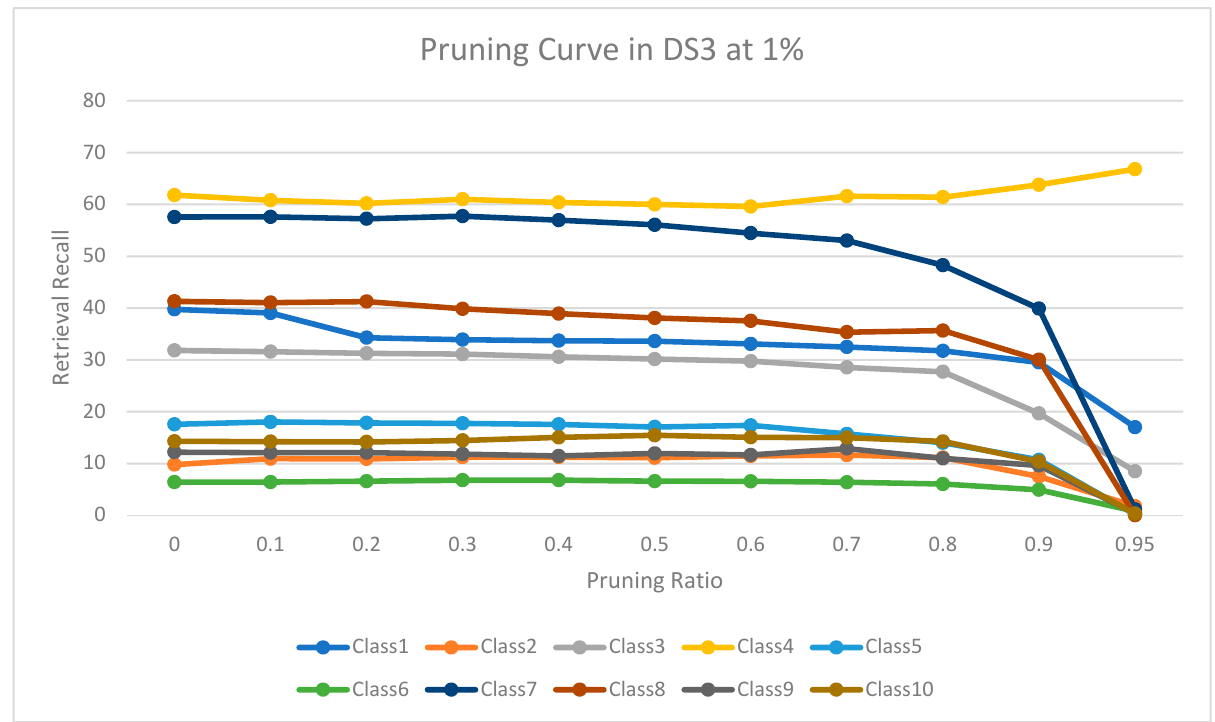
Figure 8. The level of retrieval recall values at different percentages of pruning at the top 1% in DR3-MDDR.